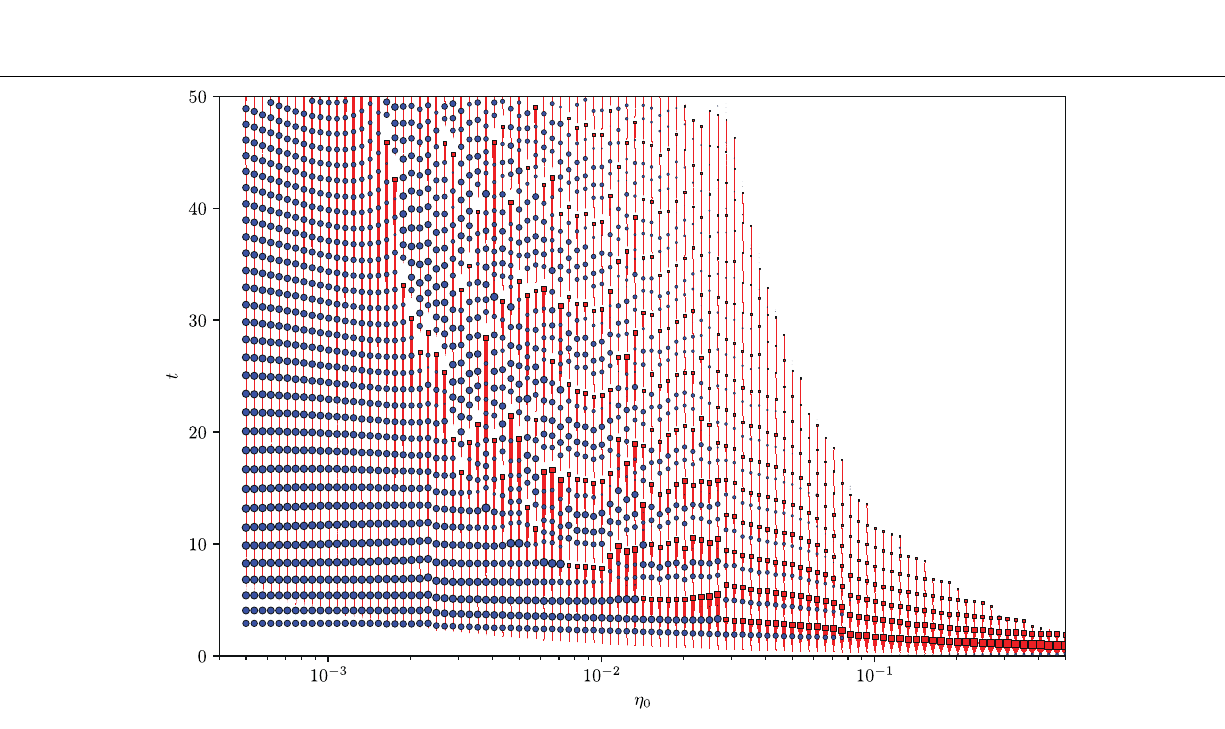
Frontiers in Astronomy and Space Sciences |